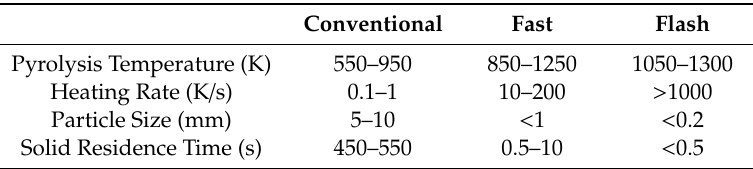
Table 1. Operating Conditions of di ff erent pyrolysis processes